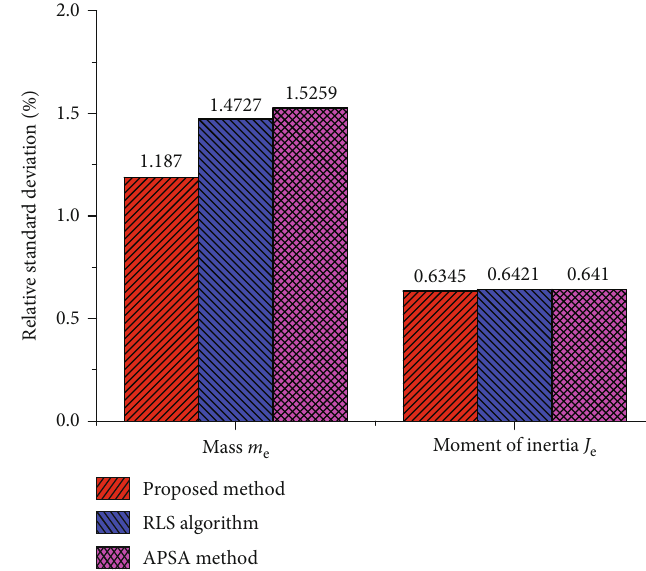
̂ J and for the three methods (10 e e